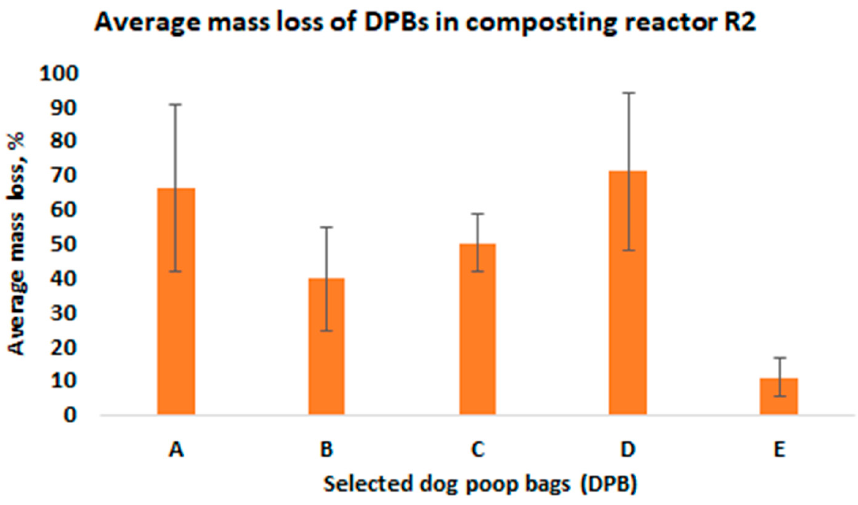
Figure 4. The average mass loss of the investigated DPBs in the composting reactor R2 after 4 weeks of composting.